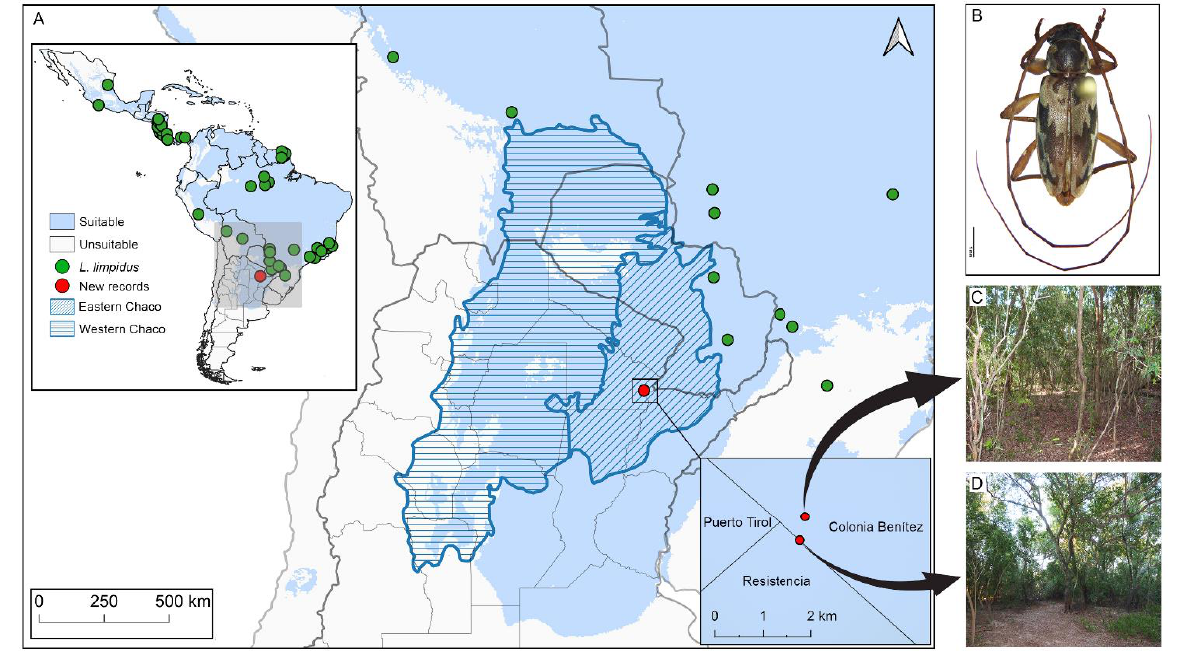
Figure 1. Climate suitability map and distribution of Lepturges limpidus . ( A ) Map shows climatic suitability recovered for Lepturges limpidus within biogeographic provinces of South America. The oblique blue lines indicate the Humid Chaco ecoregion. Green points are known distribution and red points new records reported in the present paper; ( B ) Dorsal view of Lepturges limpidus , ( C ) Private field, ( D ) Los Chaguares.